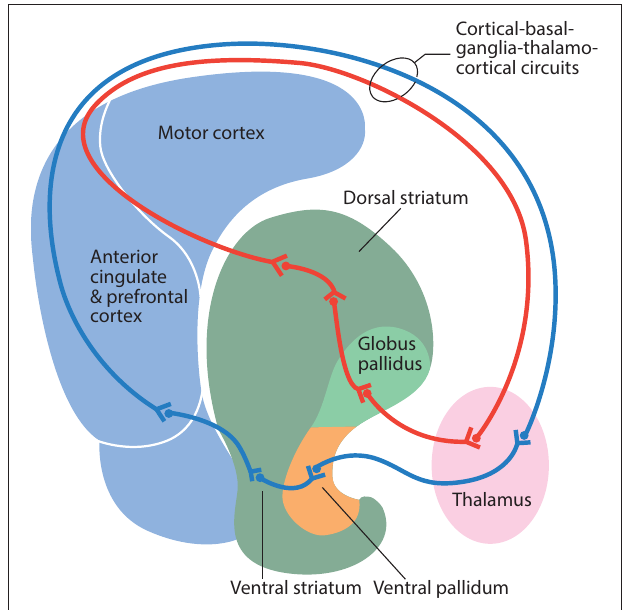
FIGURE 2 | Schematic illustration of information flow through the direct pathway in cortical-basal ganglia-thalamocortical circuits. Information from the motor cortex passes to the dorsal striatum, globus pallidus, ventral lateral thalamus, and back to the motor cortex (red line). Information from the anterior cingulate and the prefrontal cortex passes to the ventral striatum, ventral pallidum, mediodorsal thalamus, and back to the anterior cingulate and prefrontal cortex (blue